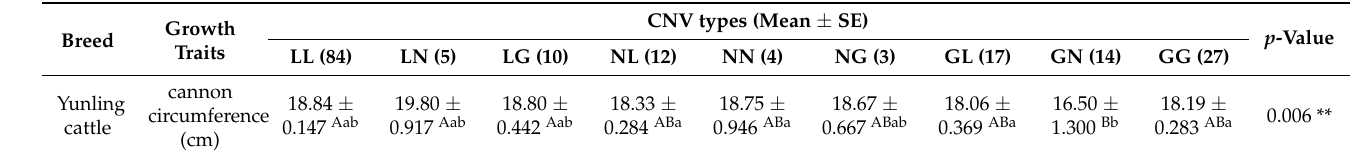
Table 4. Association analysis of CLCN2 gene CNV1 and CNV2 combination with growth traits in YL